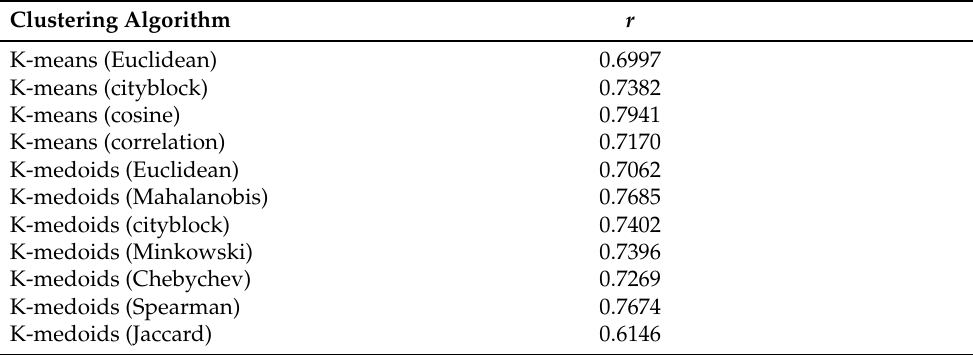
Table 1. Adjusted Rand index (0 ≤ r ≤ 1) (mean values out of 10 runs for Salinas HSI) . Clustering